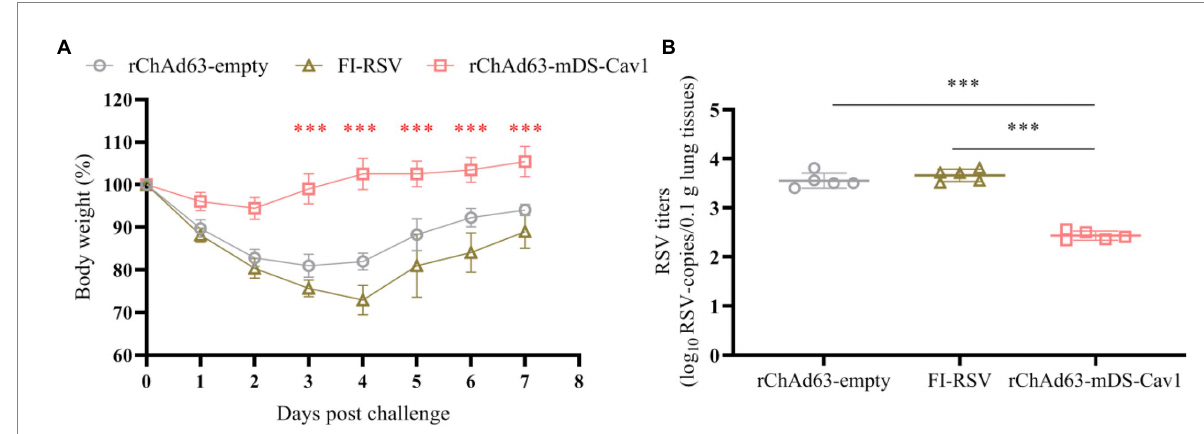
FIGURE 6 The losses of body weight and virus titers in lungs from BALB/c mice after RSV challenge.The BALB/c mice ( n = 5) were challenged intranasally with wt RSV-Long strain (1 × 10 6 PFU/mouse) at day 28 after the immunization. (A) The losses of body weight were observed daily for 7 consecutive days in which 100% body weight was set at day 0 when the mice were challenged. (B) Lung RSV titer were measured by RT-qPCR at day 5 after the challenge. Data were shown as mean ± SD, *** p <